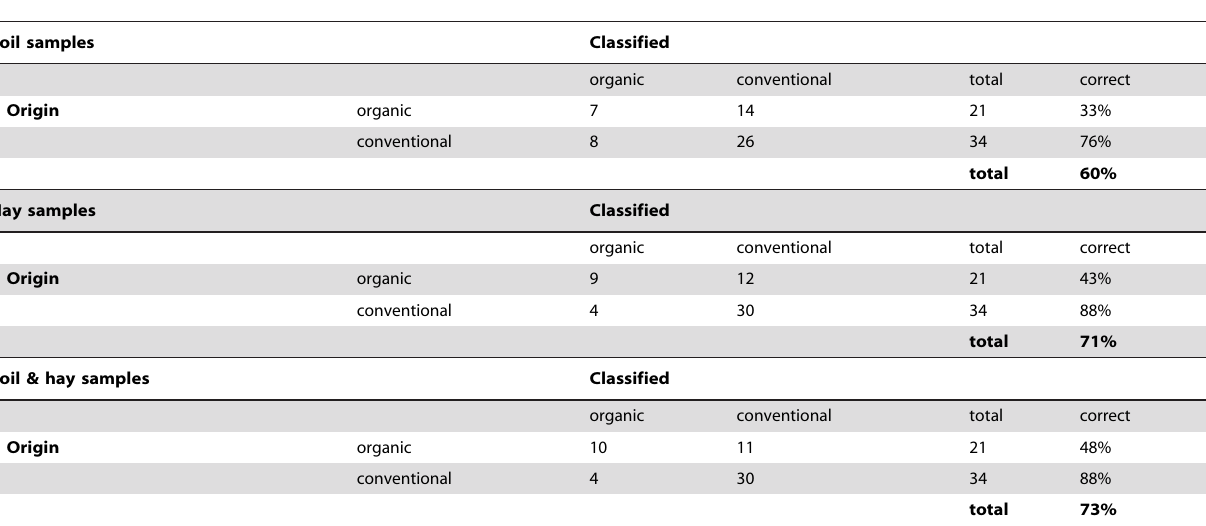
Table 3. Results of quadratic discriminant analysis (QDA) of management types (organic vs. conventional) deduced from regionally standardized d 15 N and d 13 C isotopic abundances of soil and/or hay samples of grasslands.